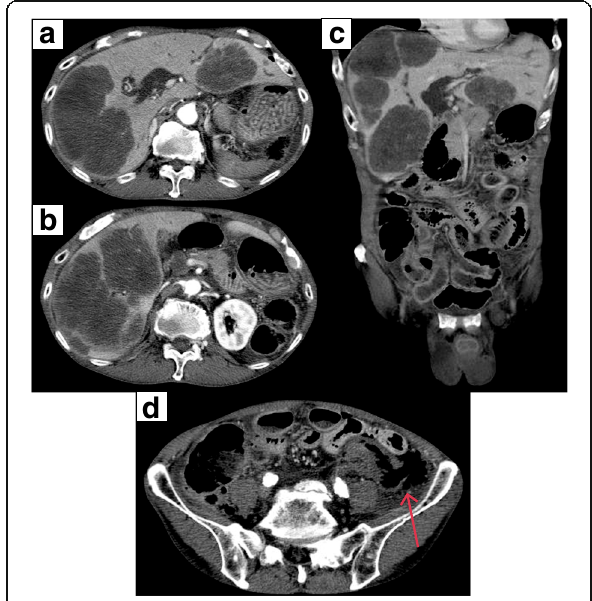
Fig. 1 CT scan of the abdomen. a – c Multiple liver metastases were revealed. d Abdominal free air and perforating sigmoid colon cancer (arrow) were revealed